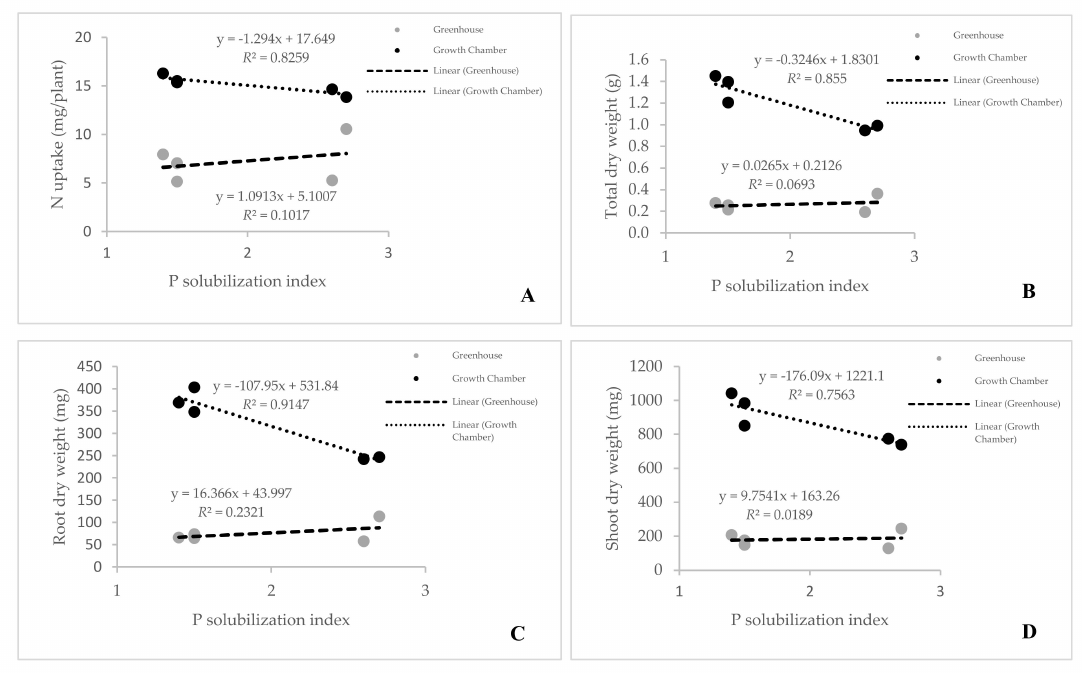
Figure 1. Regressions between bacterial inorganic phosphate solubilization index and N uptake ( A ), total plant dry weight ( B ), root dry weight ( C ), and shoot dry weight ( D ) of upland rice under greenhouse and growth chamber conditions. Data under growth chamber were collected 30 DAI, and 60 DAI under greenhouse